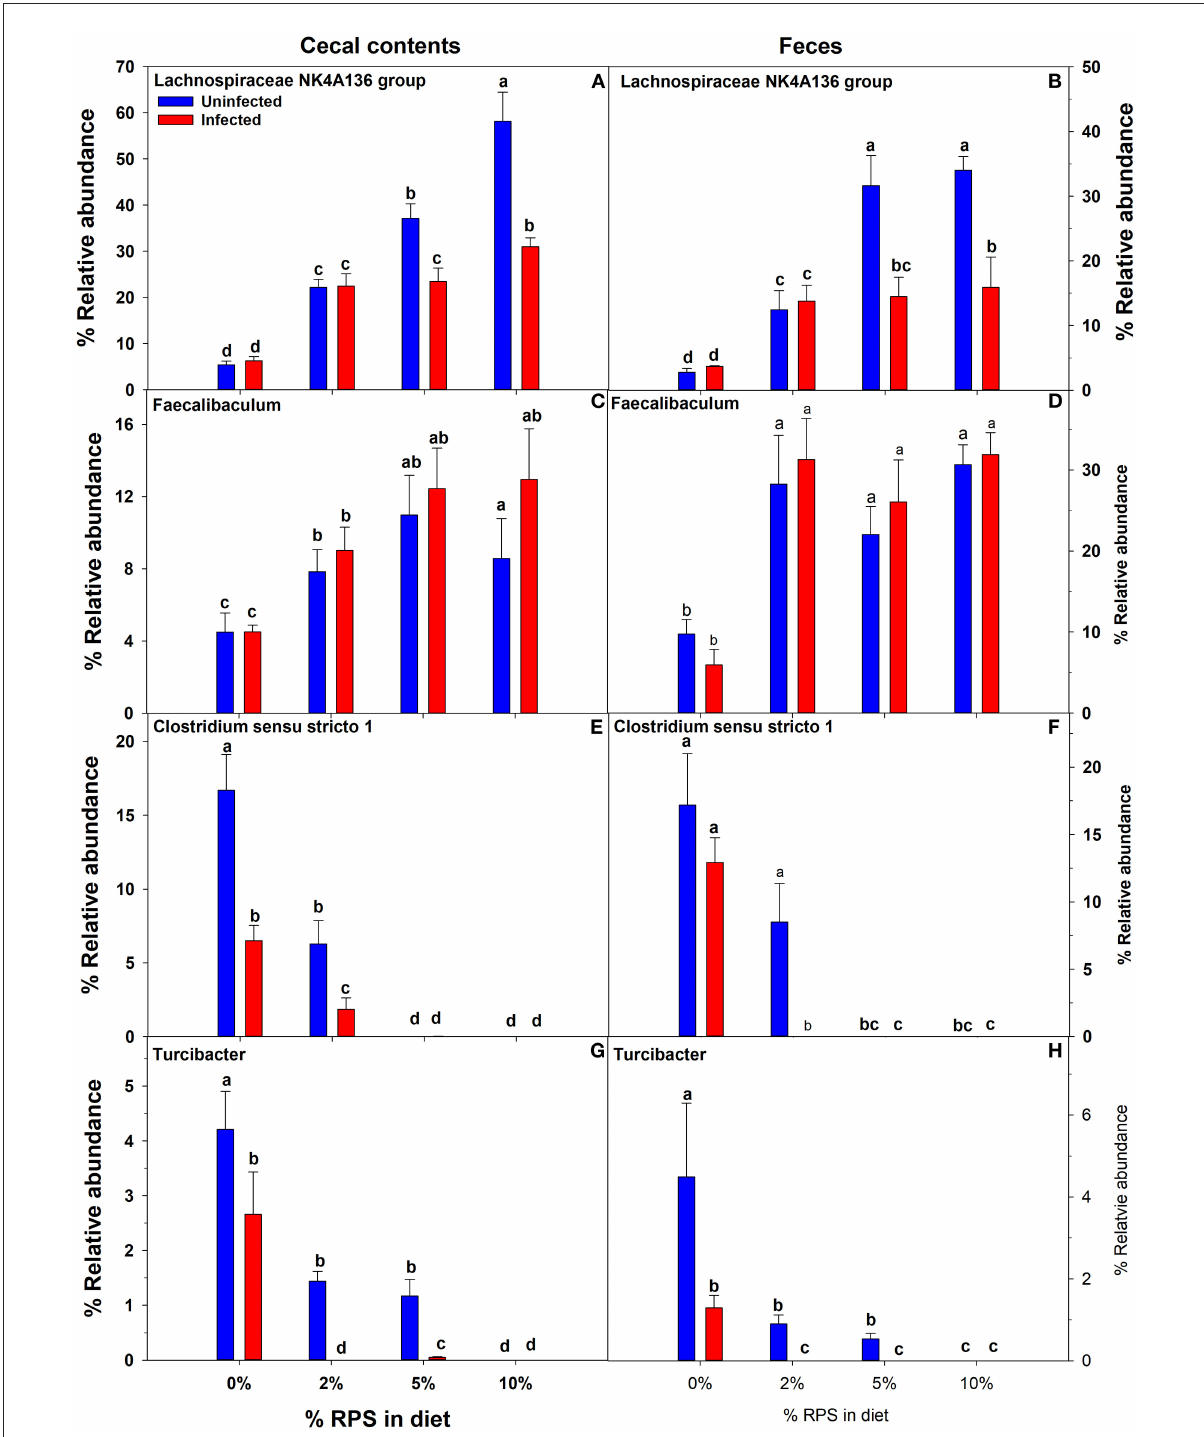
FIGURE5 Both feeding RPS diets and Cr infection altered the relative abundance of various genera in cecal and fecal samples. Cecal samples obtained 12 days post-infection and fecal samples obtained 6 days post-infection from uninfected and infected mice were subjected to 16S sequencing and analysis. Shown are examples were diet and infection altered the relative abundance of (A, B) Lachnospiraceae NKA136 group , (C, D) Faecalibaculum (E, F) Clostridium sensu stricto 1 , and (G, H) Turcibacter . Bars are means ± SEM. Groups with different letters are significantly different by two way ANOVA, p < 0.05, n =